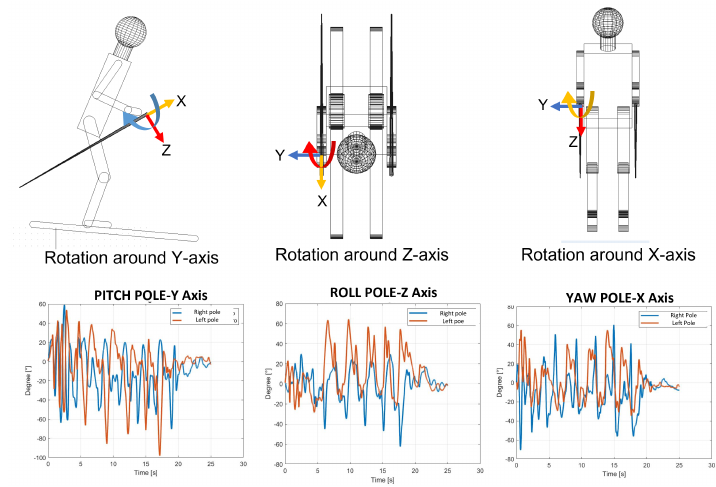
Figure 11. Roll, yaw and pitch angles for